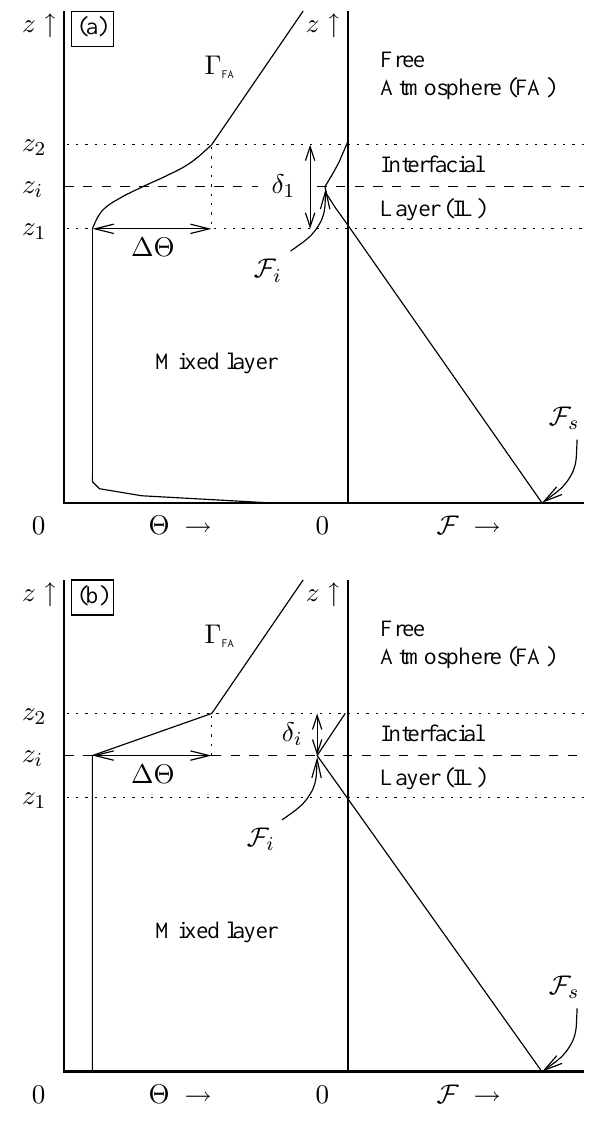
Fig. 1. (a) Typical vertical profiles of potential temperature Θ and heat flux F for the convectively-driven boundary layer. (b) Same as (a) for the ‘first-order’ model proposed by Betts (1974) (referred to as ‘FOM1’ in § 4.4). All parameters are defined in the text.